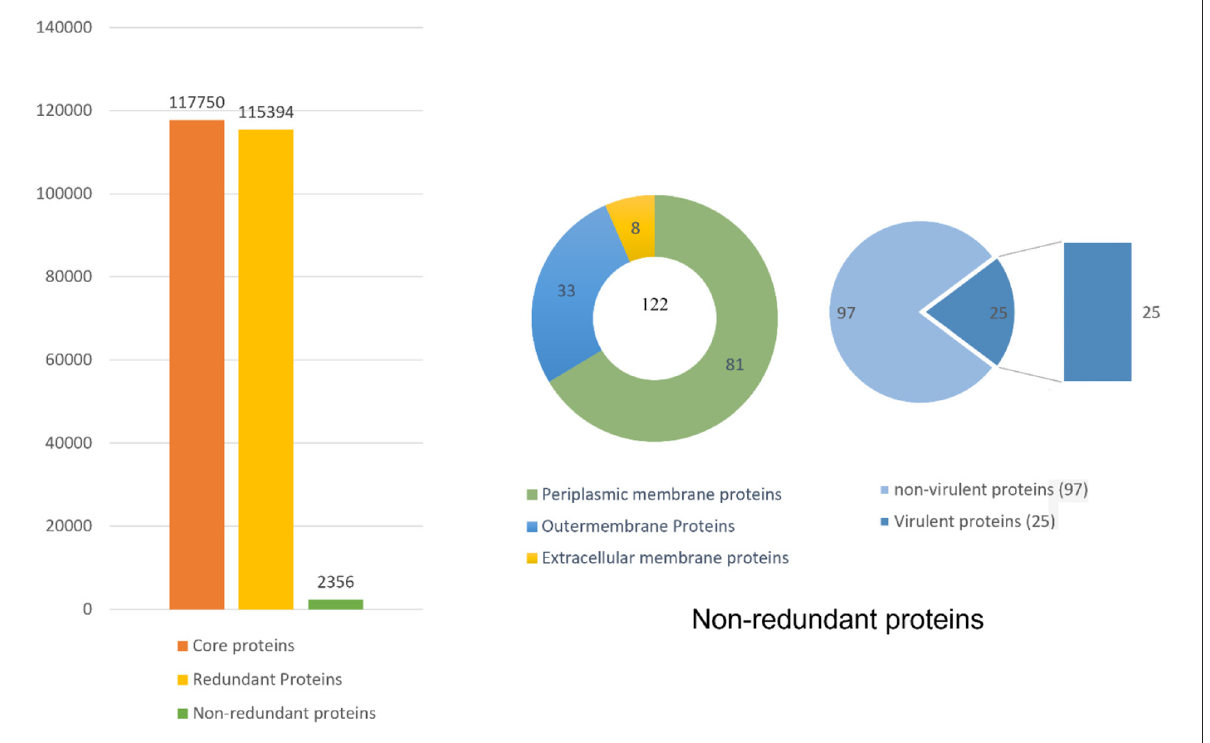
FIGURE2 Complete detail of the total retrieved and shortlisted